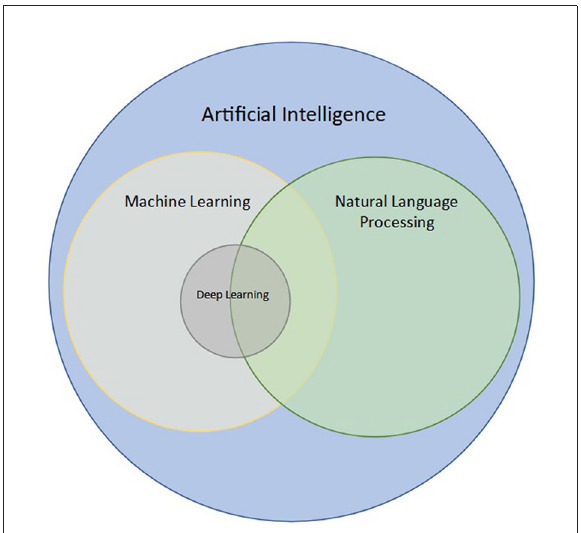
FIGURE1 Intersection of natural language processing (NLP) with artificial intelligence (AI), machine learning (ML), and deep learning (DL). NLP is a branch of AI concerned with processing and analyzing text data. ML is a subfield of AI aimed at modeling data, and DL is a subfield of ML that uses neural networks to analyze large datasets. NLP techniques may utilize ML and DL when used for classification of words, sentences, or even